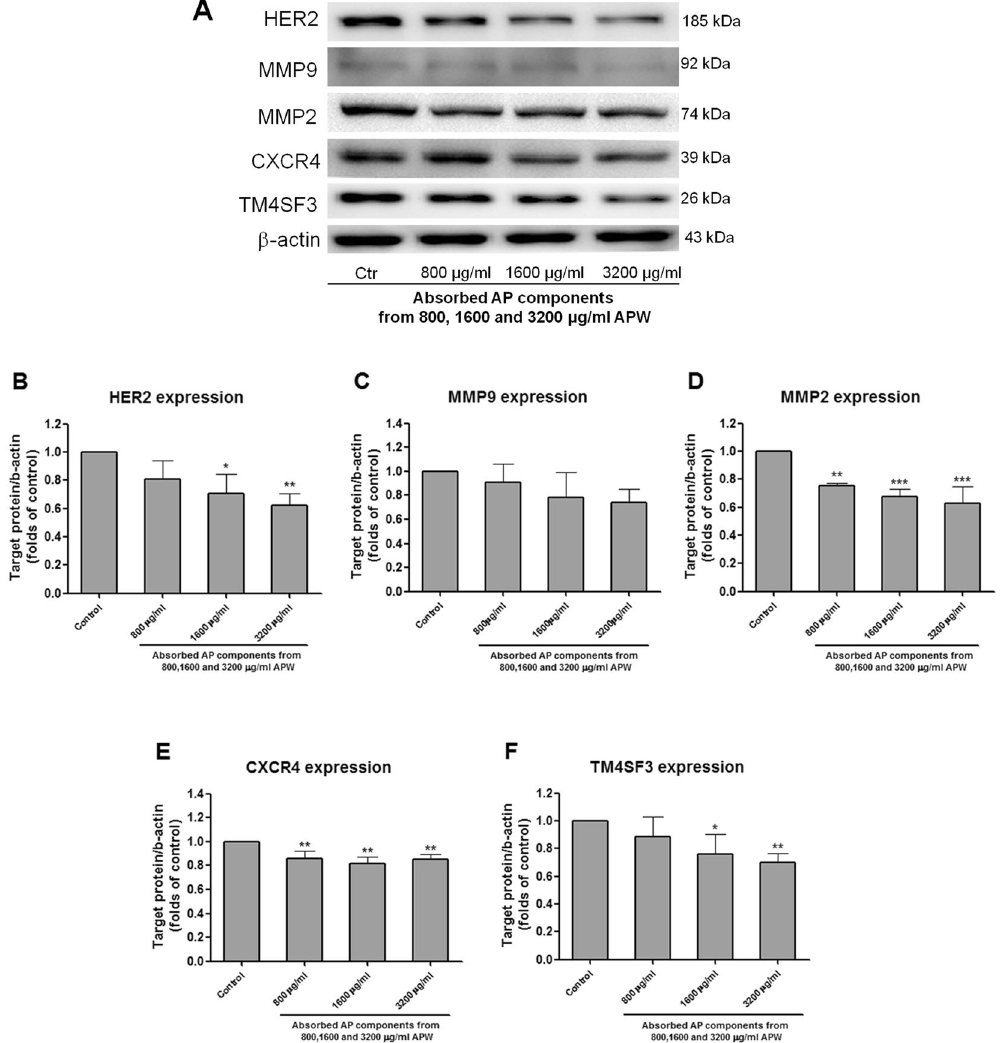
Figure 4. Western blot analysis of the expression of metastasis-related proteins. ( A ) Representative immunoblots showing the effects of absorbed AP components from 800, 1600 and 3200 μ g/ml APW on EC-109 cellular expression of HER2, MMP9, MMP2, CXCR4, TM4SF3. Actin expression was determined to confirm equal protein loading. ( B – F ) The histograms showed quantified results of protein levels, which were adjusted with corresponding β -actin protein level and expressed as folds of control (mean fold of control + S.D. of three independent experiments). Differences among all groups were determined by one-way ANOVA followed by post-hoc Tukey’s multiple comparison test, * p < 0.05, ** p < 0.01, *** p < 0.001 as compared with vehicle